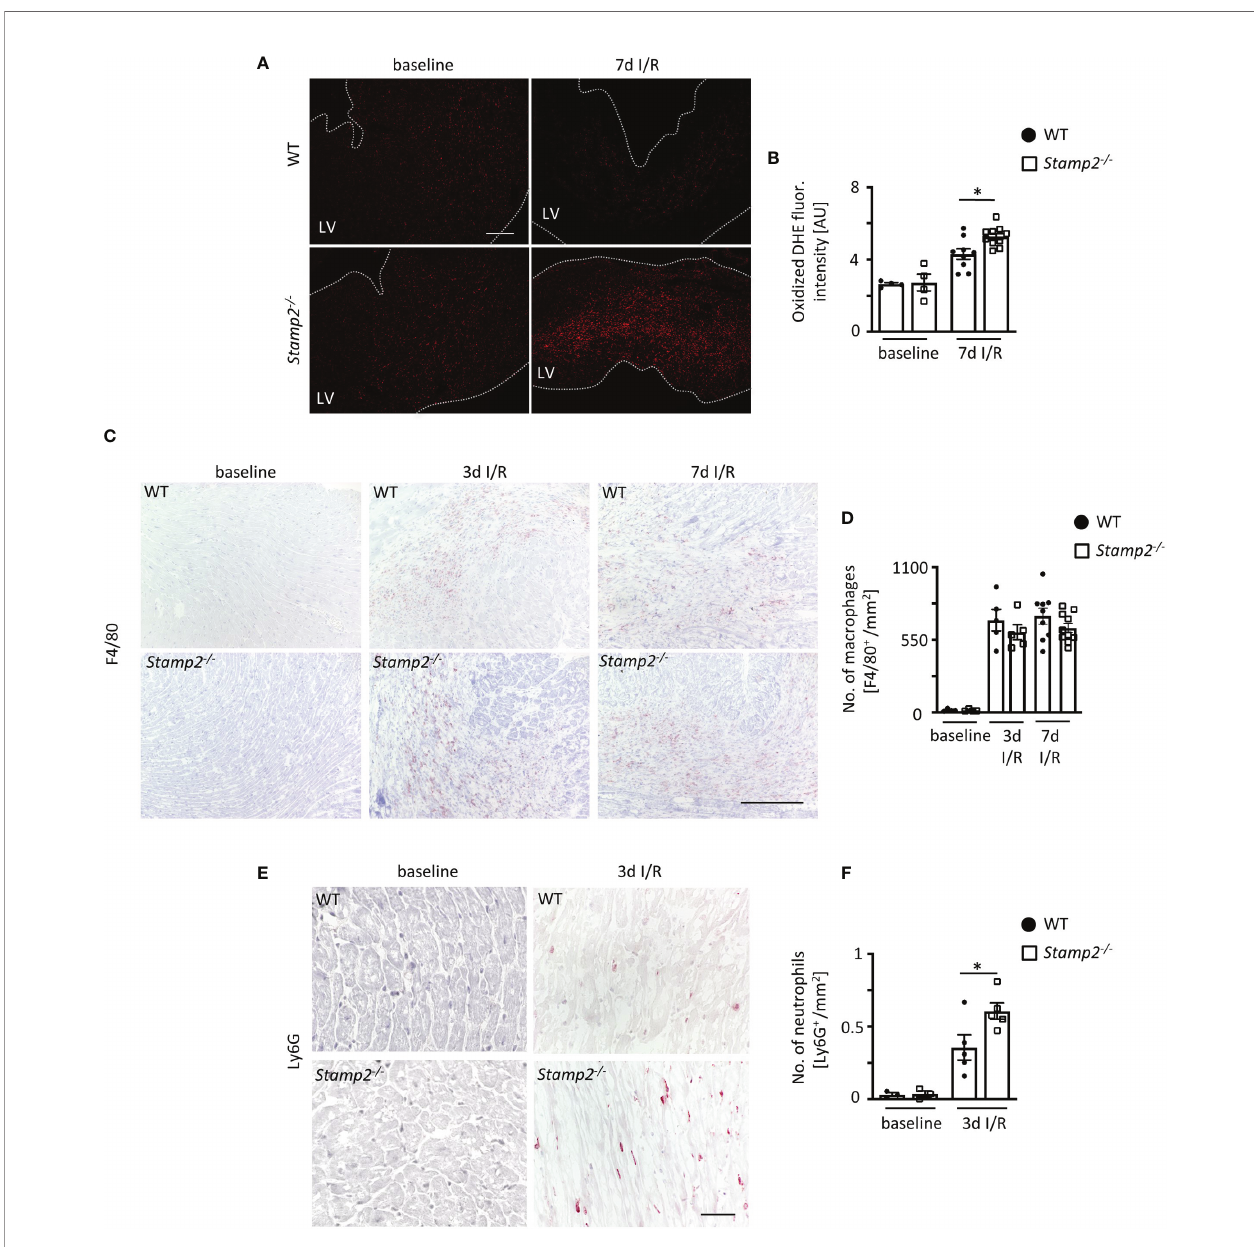
FIGURE 3 | Stamp2 regulates myocardial PMN in fi ltration after I/R. (A) Representative stainings of oxidized dihydroethidium (DHE) and (B) quantitative analysis of ROS production in myocardial sections 7 days after I/R induction (n=4/4/7/8). Scale bar=200 m m. (C) Representative left ventricular immunohistological stainings for the pan-macrophage marker F4/80 (brown) and (D) quantitative analysis of macrophage numbers within the infarct region (n=4/4/5/5/9/10). Scale bar= 200 m m. (E) Representative left ventricular immunohistological stainings for the PMN marker Ly6G (brown) and (F) quantitative analysis of neutrophil numbers within the infarct region 3 days after I/R induction (n=3/3/5/5). Scale bar = 50 m m. Graphs show Mean ± SEM. Signi fi cance was determined by two-way ANOVA followed by Tukey post-hoc test. *P <